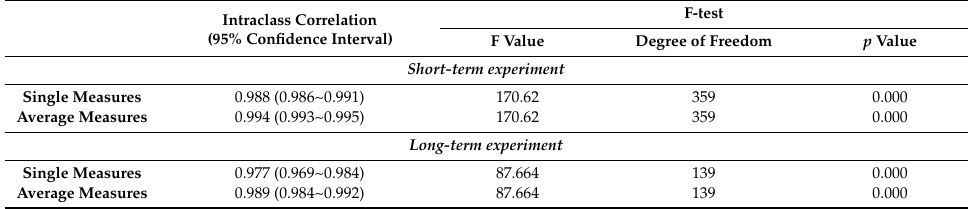
Table 6. Results of intraclass correlations on di ff erences in the short-term